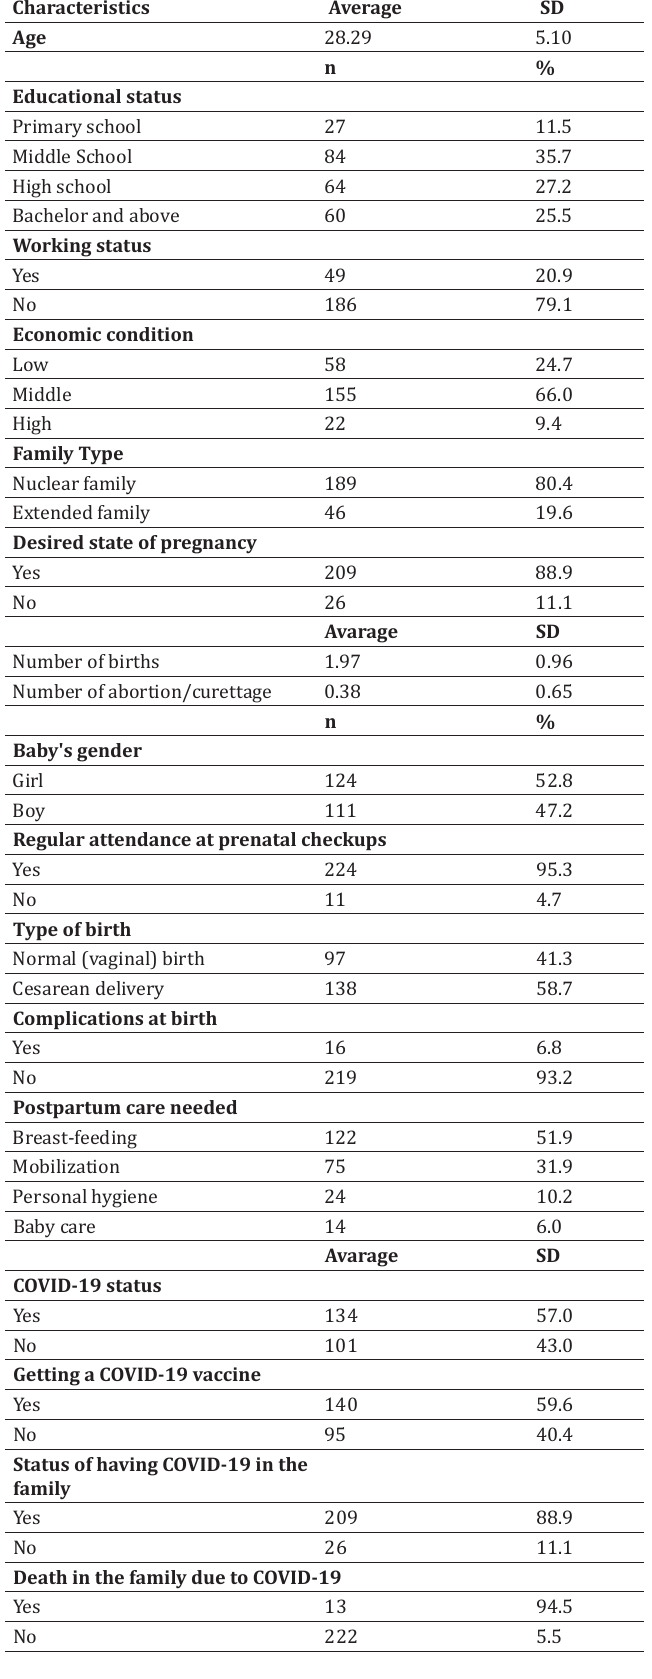
Socio-Demographic, Obstetric and COVID-19- Related Characteristics of Women (n=235) Characteristics